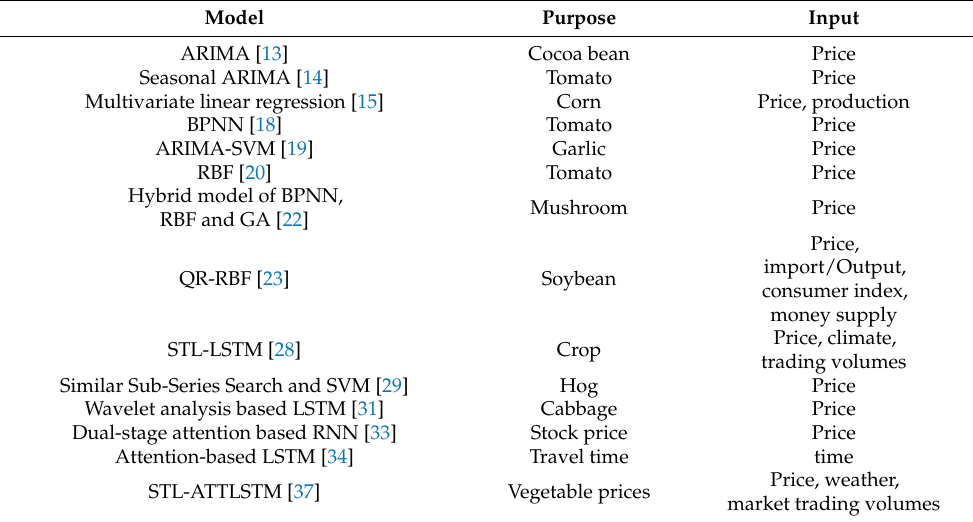
Table 1. Summary of the literature